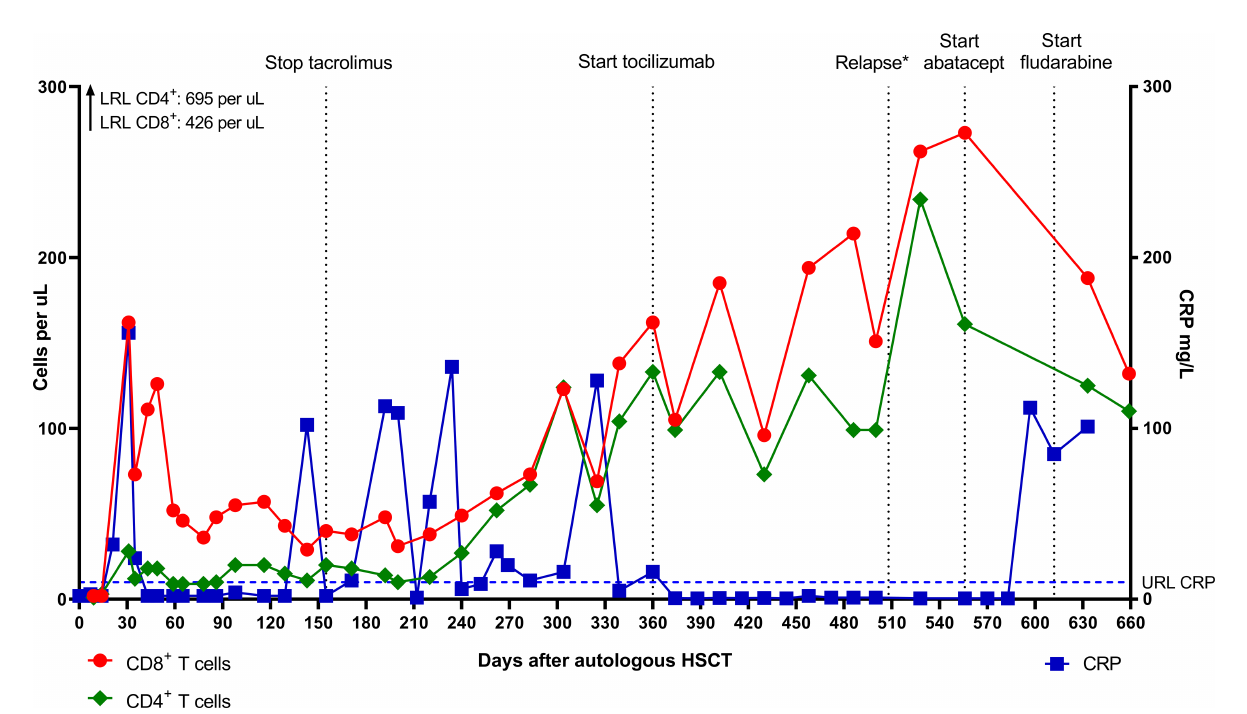
FIGURE 3 | Absolute CD8 + and CD4 + T cell numbers and CRP levels after autologous HSCT. *Relapse on day 508 was characterized by clinical symptoms and disease activity on F-18-FDG PET scan. CRP level was probably not elevated due to the masking effect of tocilizumab (10). LRL, lower reference limit; URL, upper reference limit; CRP, C-reactive protein; HSCT, hematopoietic stem cell transplantation; PET, positron emission